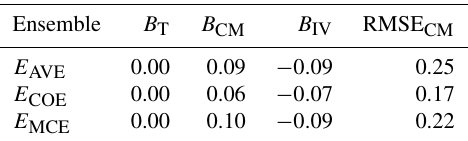
Table 4. Model-as-truth performance comparison of different meth- ods on CMIP5 data, median of trend bias ( B T ), climatological monthly bias ( B CM ), interannual variability bias ( B IV ) and clima- tological monthly RMSE (RMSE CM ) on validation